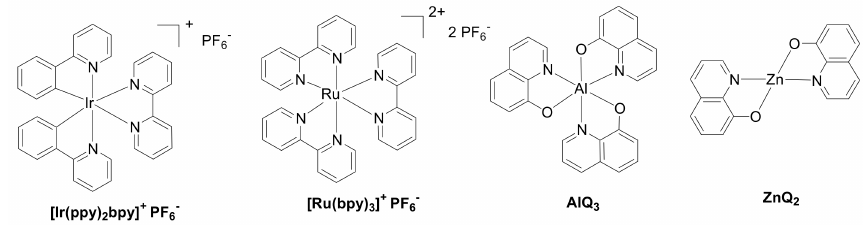
Figure 1. Chemical structures of organometallic